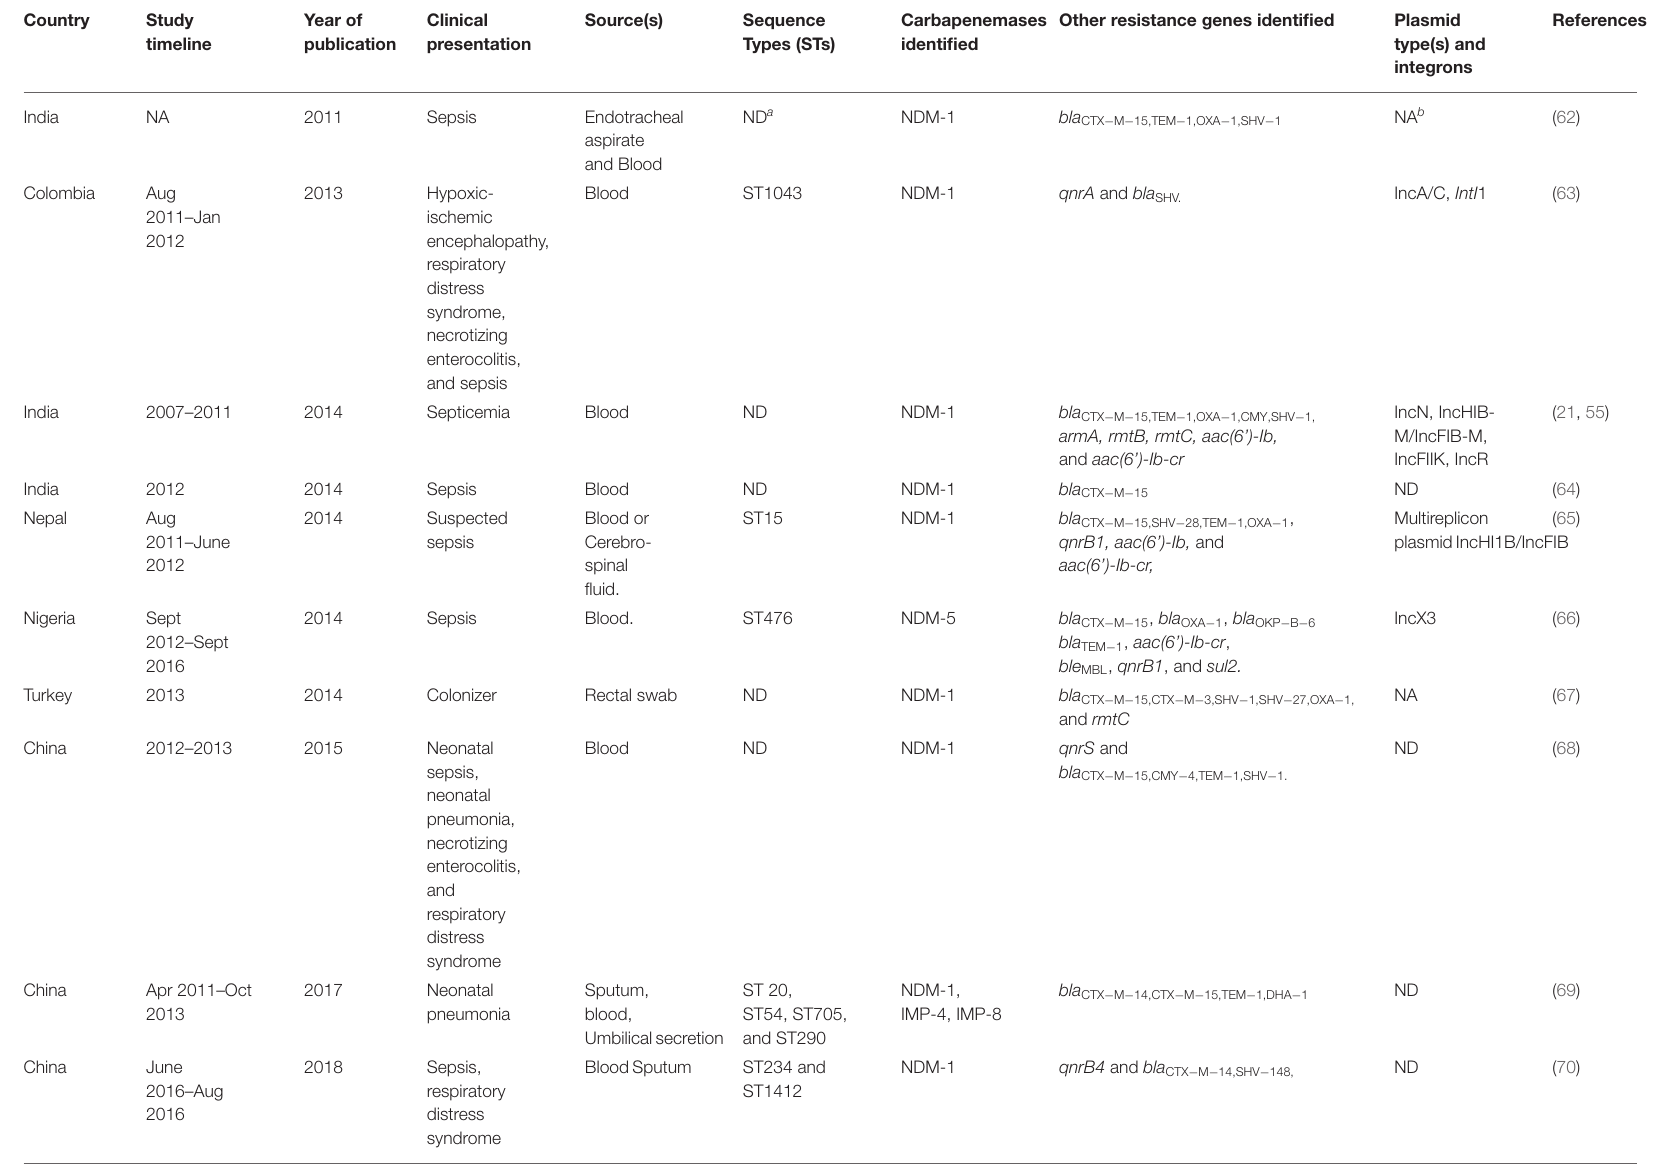
TABLE 1 | Carbapenem-resistant K. pneumoniae causing neonatal septicemia or intestinal colonization.